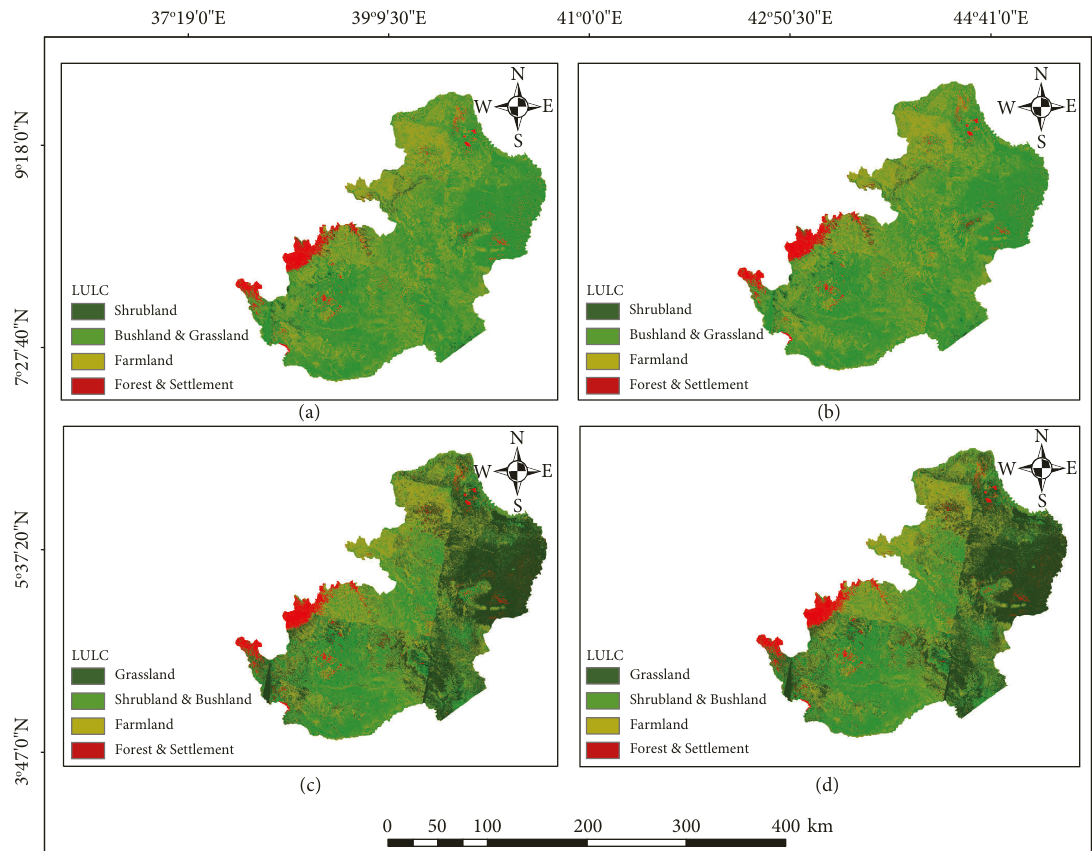
Figure 2: LULC factor livestock production map for (a) goat, (b) camel, (c) sheep, and (d)